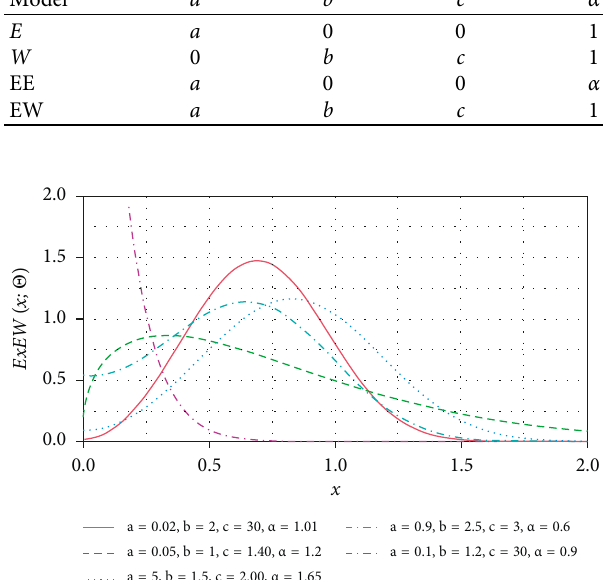
Table 1: Submodels of the ExEW( a , b , c , α ) distribution. Model